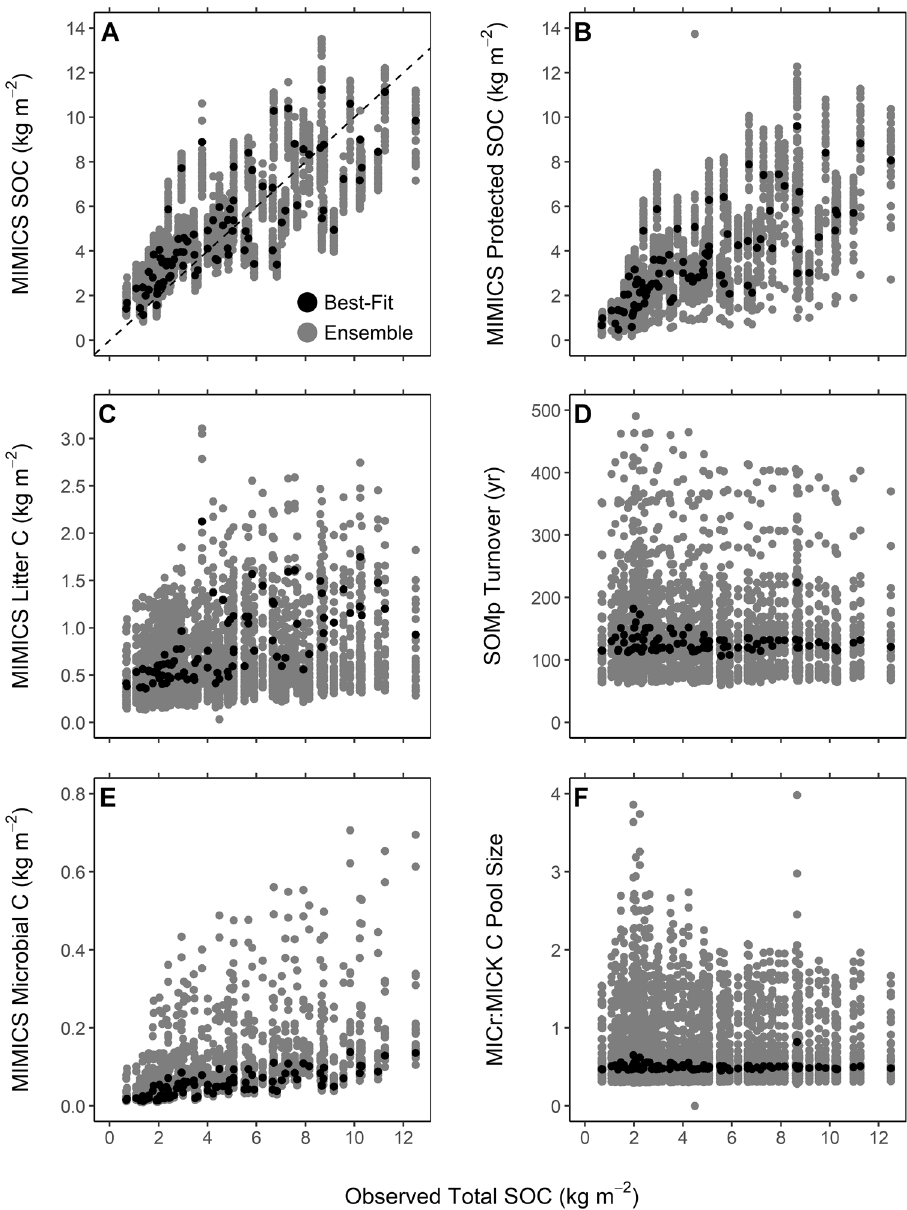
Figure 4. MIMICS estimate variability relative to observed SOC stocks for the best (lowest RMSE) MC determined parameterization and a larger ensemble of MIMICS model parameterizations (n = 30) with SOC stock estimate RMSE < 2. (Generated by free software R, https:// www.R- proje ct.